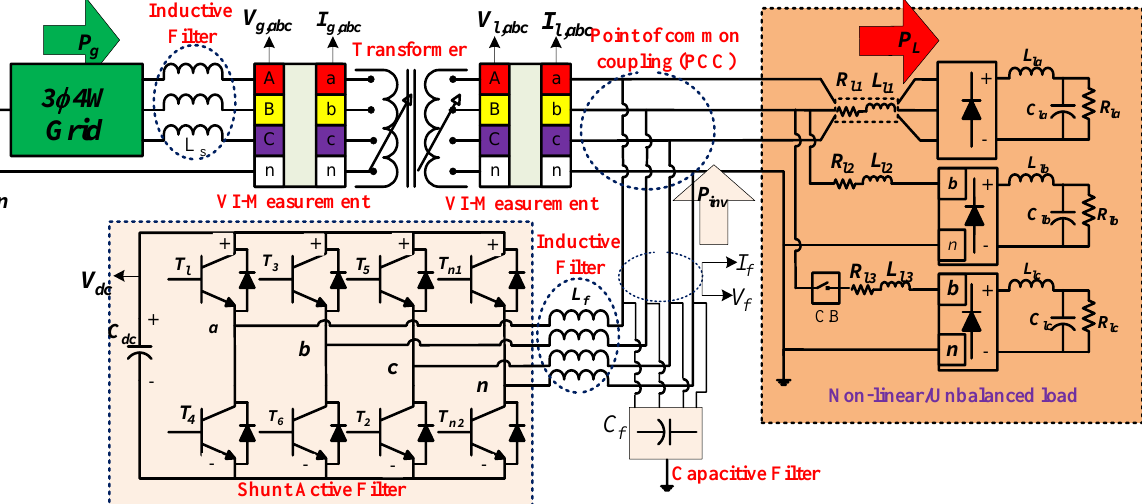
Figure 1. A 3 𝜑 4W SAF_based coordinated power system schematic diagram. Figure 1. A 3 ϕ 4W SAF_based coordinated power system schematic